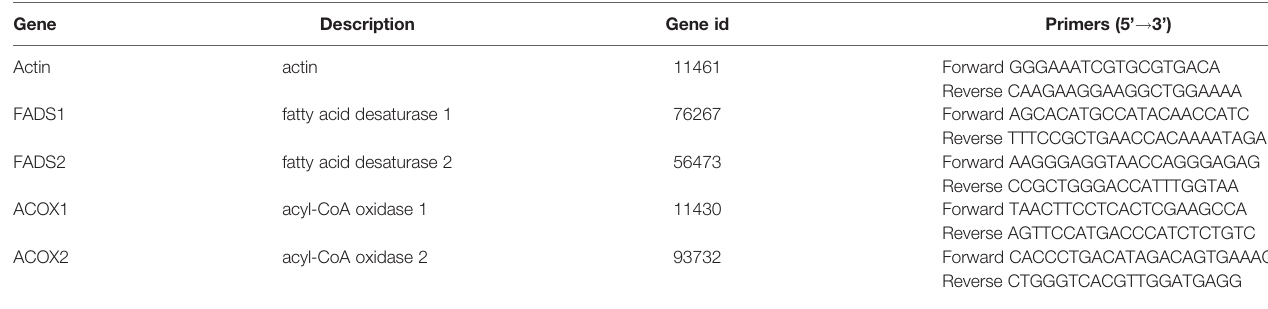
TABLE 3 | mRNA primer